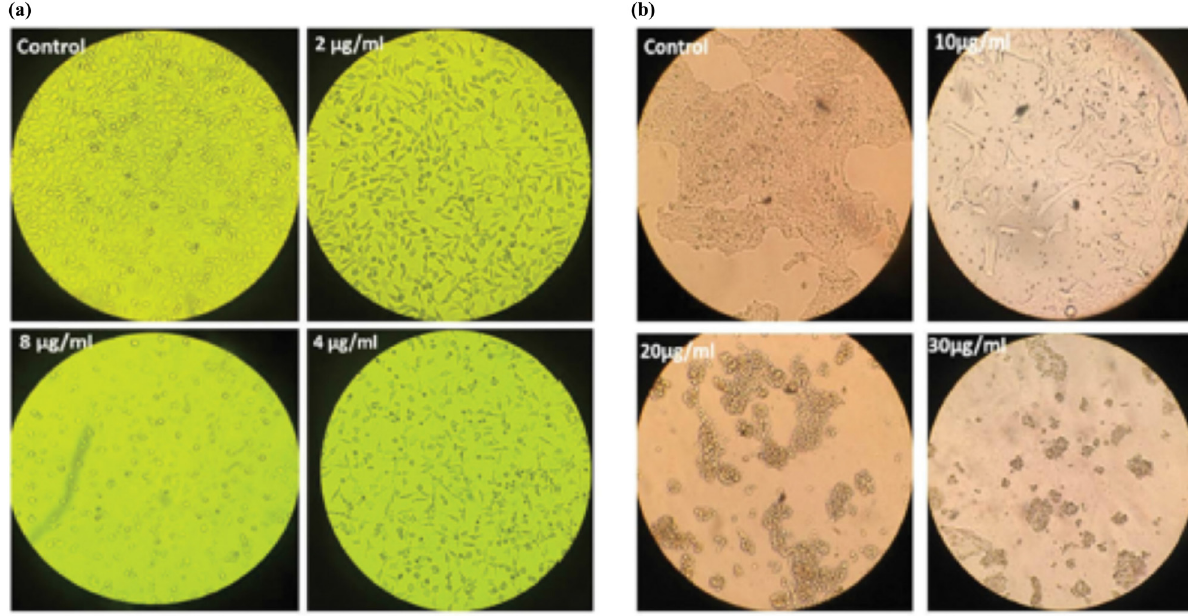
Figure 14: Flow cytometry detection of the morphology and cell cycle status of treated cell lines. ( a ) MCF7 cell line morphology at various ZnONPs treatment doses compared to untreated control cells. At high concentrations, their morphology shows apoptotic death. ( b ) The morphology of the TUBO cell line after various doses of ZnONPs treatment in comparison to untreated control cells. At high ZnONPs concentrations, apoptotic death might also be observed in the MCF7 cell line [ 67 ] . Copyright © 2019; Wiley Online Library.